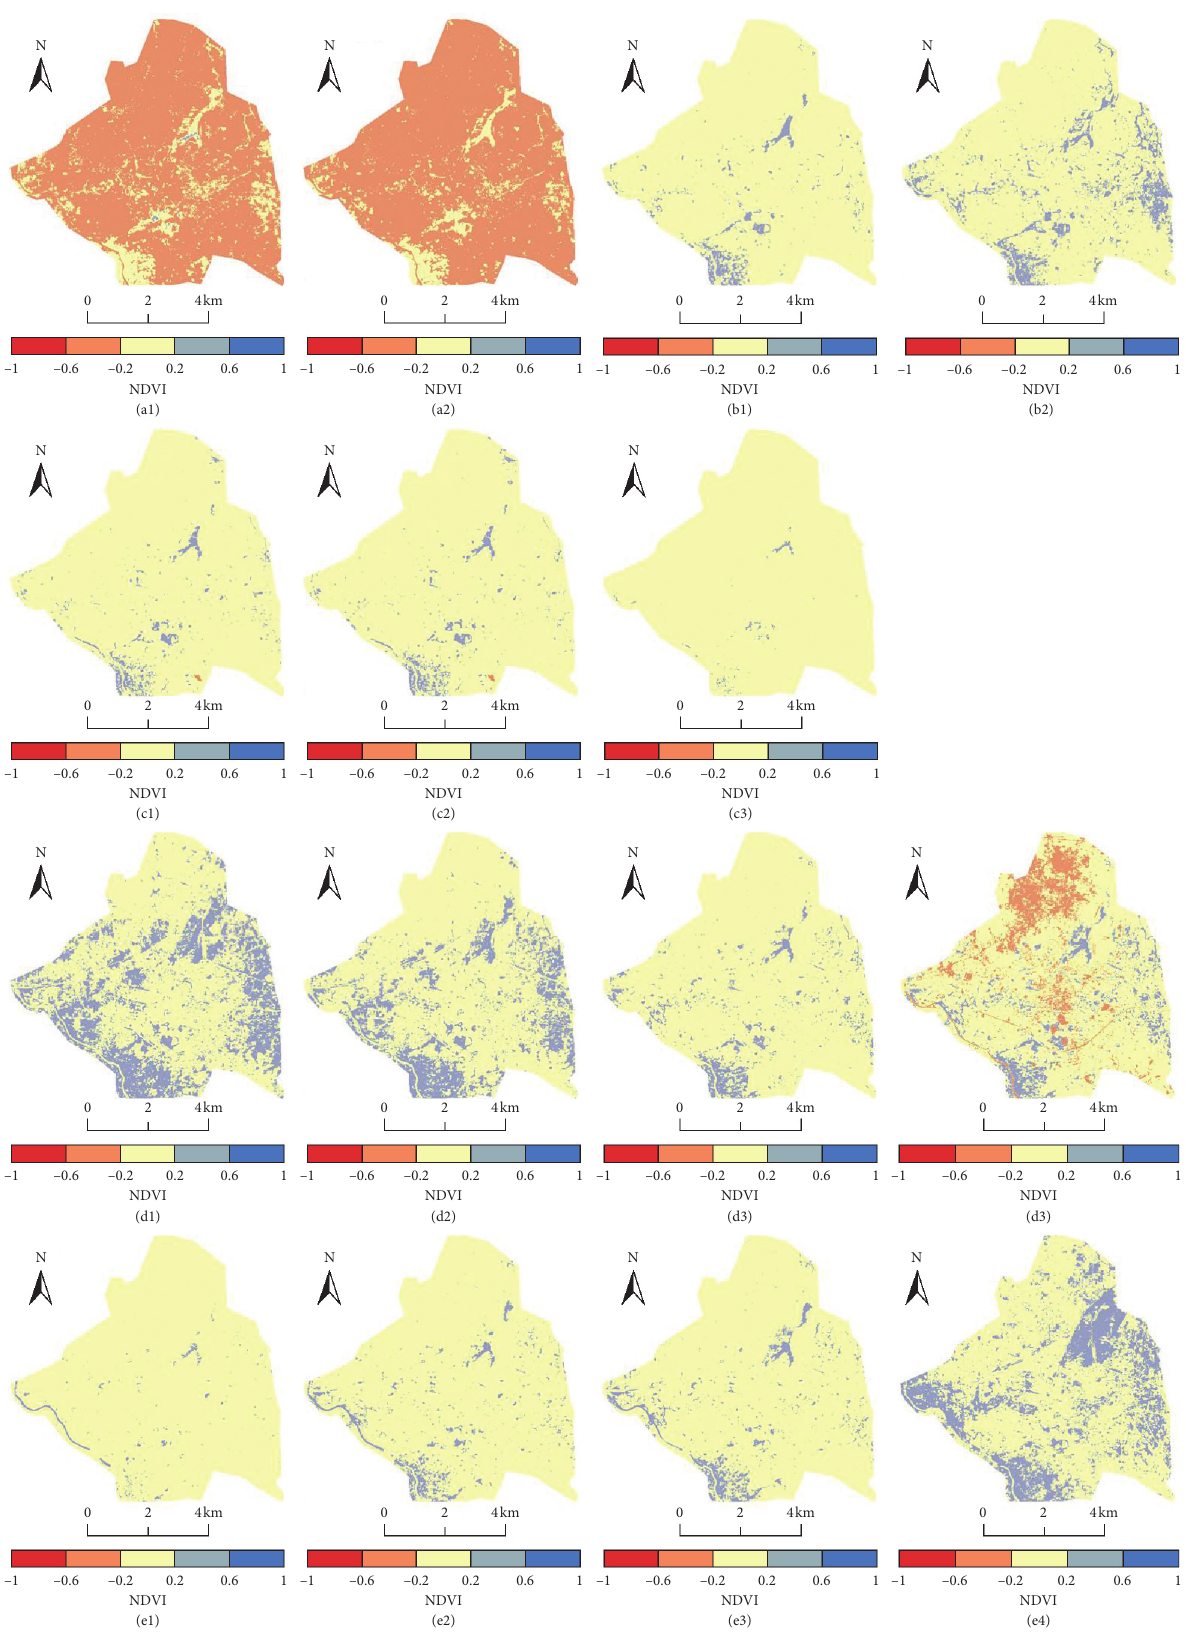
Figure 4: Variation in the distribution of NDVI: (a1-a2) 2002 (b1-b2) 2006 (c1-c3) 2010 (d1-d4) 2014 (e1-e4)